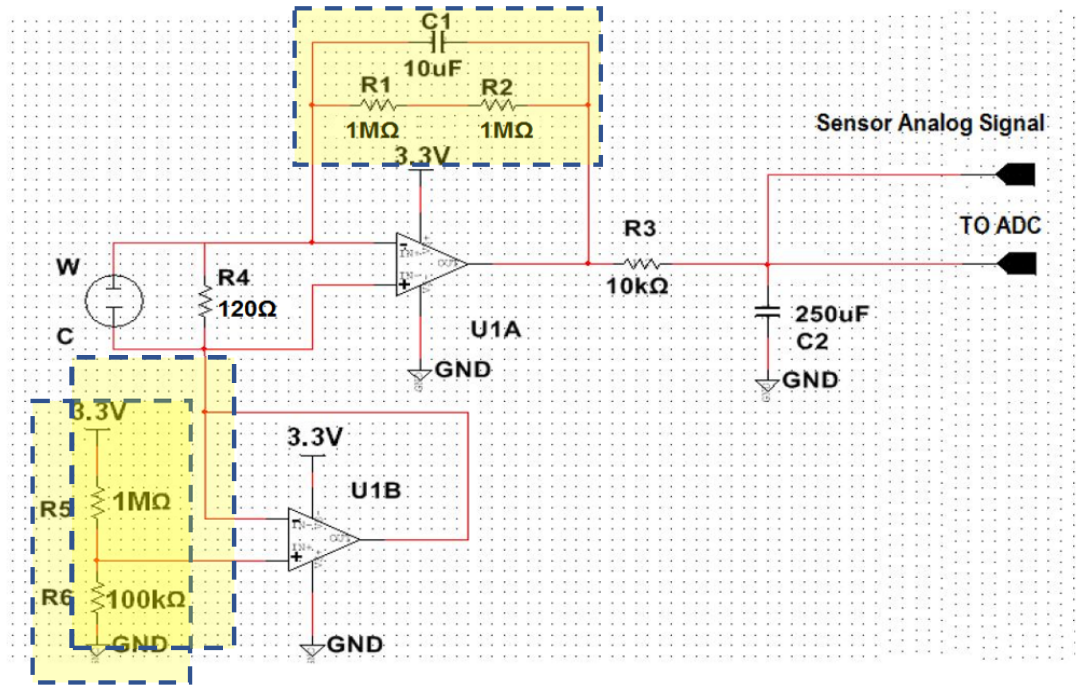
Figure 9. Schematic of potentiostatic stage used for conditioning the current signal provided by the ME2-CO and ME2-CH2O sensors.